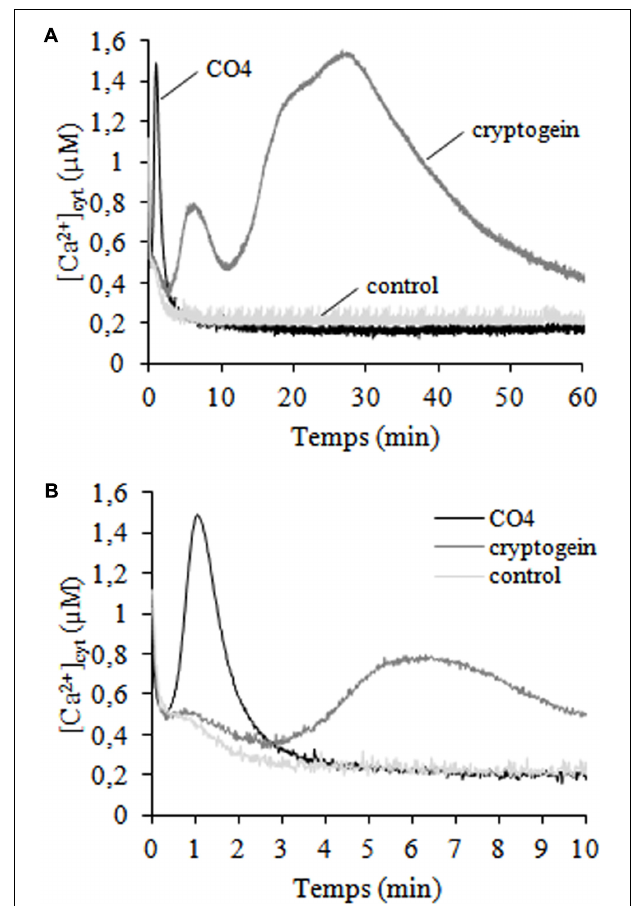
FIGURE 1 | Time courses of cytosolic free calcium concentrations ([Ca 2 + ] cyt ) induced by CO4 and cryptogein. Control, 100-nM CO4- and 50-nM cryptogein- treated cells. (A) [Ca 2 + ] cyt was measured for 60 min in an N. tabacum cv. Xanthi cell line expressing cytosolic aequorin and based on a bioluminescence calibration curve. The curves in graph (B) correspond to the first of graph (A) . Data correspond to one representative experiment out of four. Mean values ± SEs are given in Supplementary Table